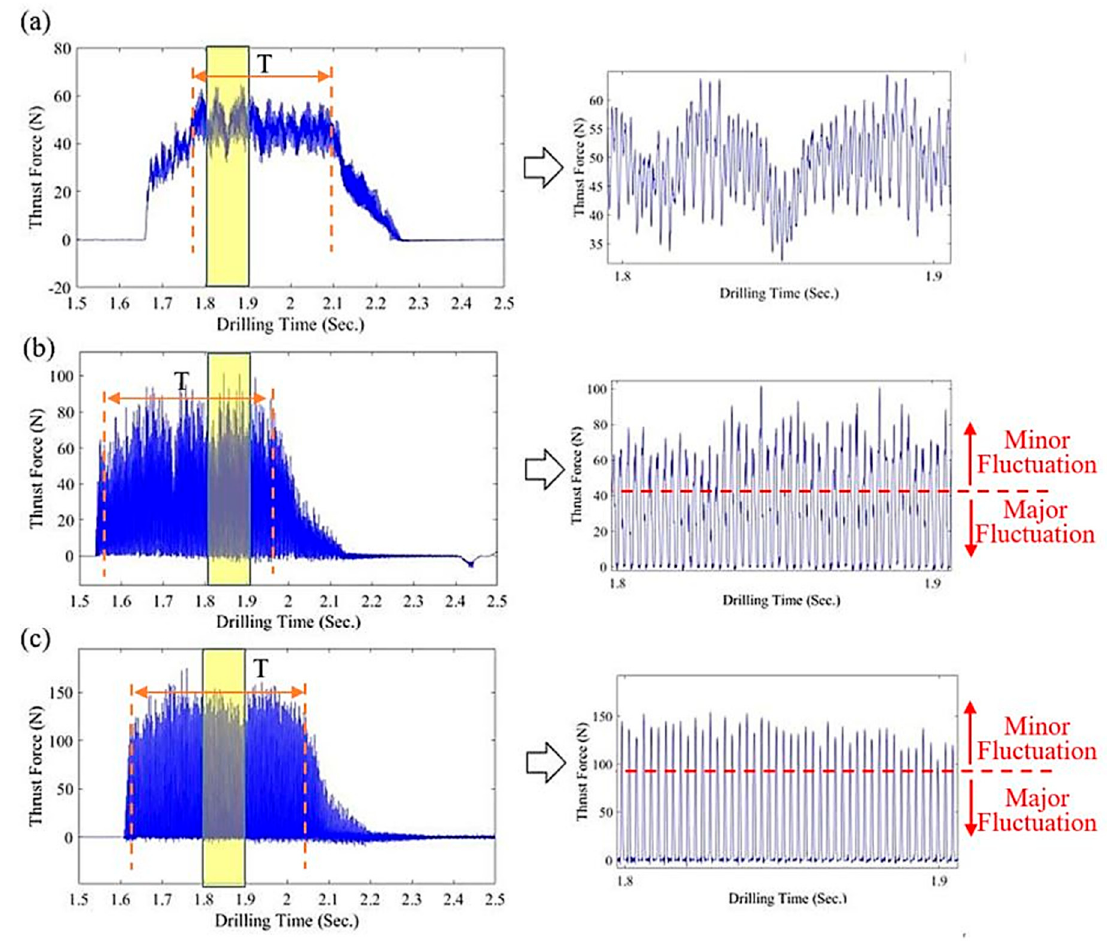
Figure 5. Effect of the LF-VAD on the thrust force profile at f = 0.075 mm/rev and N = 3000 rpm for ( a ) CD ( b ) A m = 0.07 mm ( c ) A m = 0.48 mm.